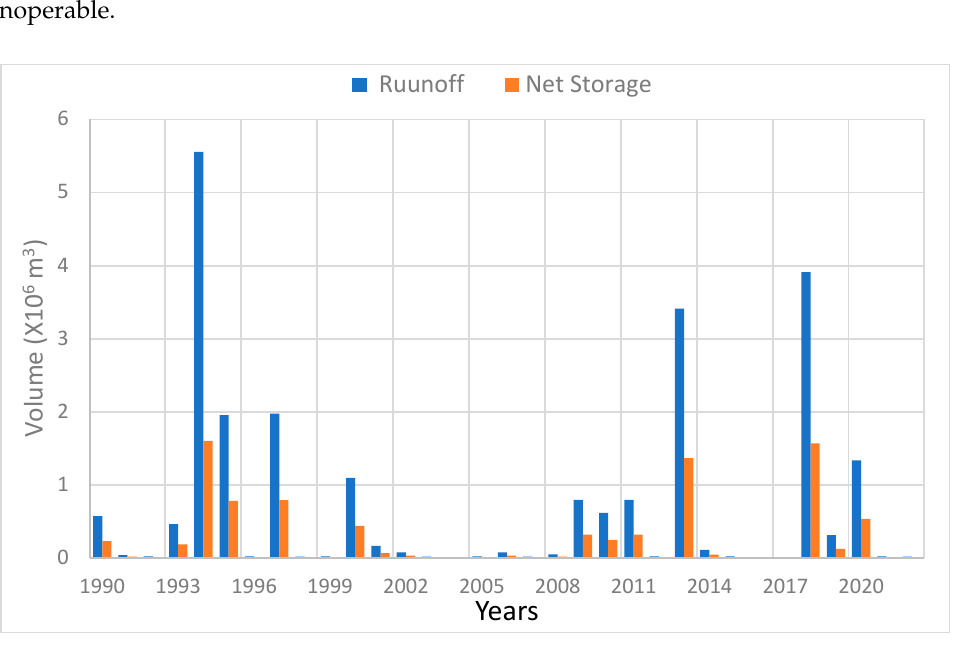
Figure 2. The total annual runoff volume and net storage volume.